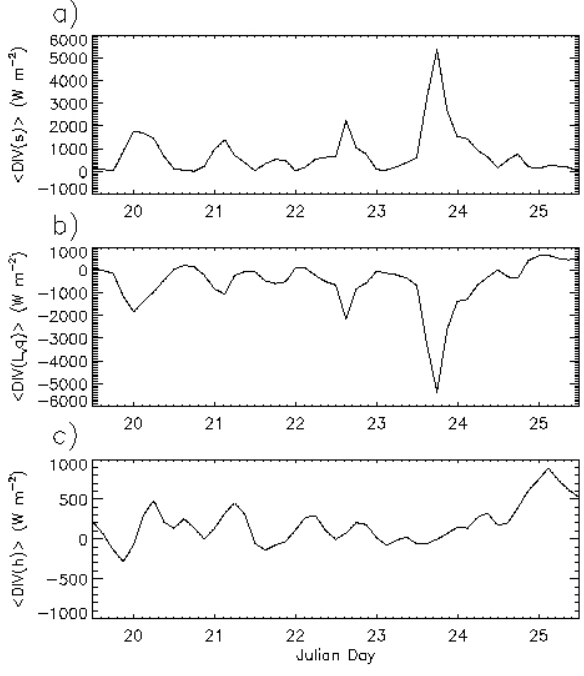
Fig. 3. As in Fig. 2, except timeseries of horizontally-averaged vertically-integrated time tendencies: (a) ∂ ∂ h h i . ∂t